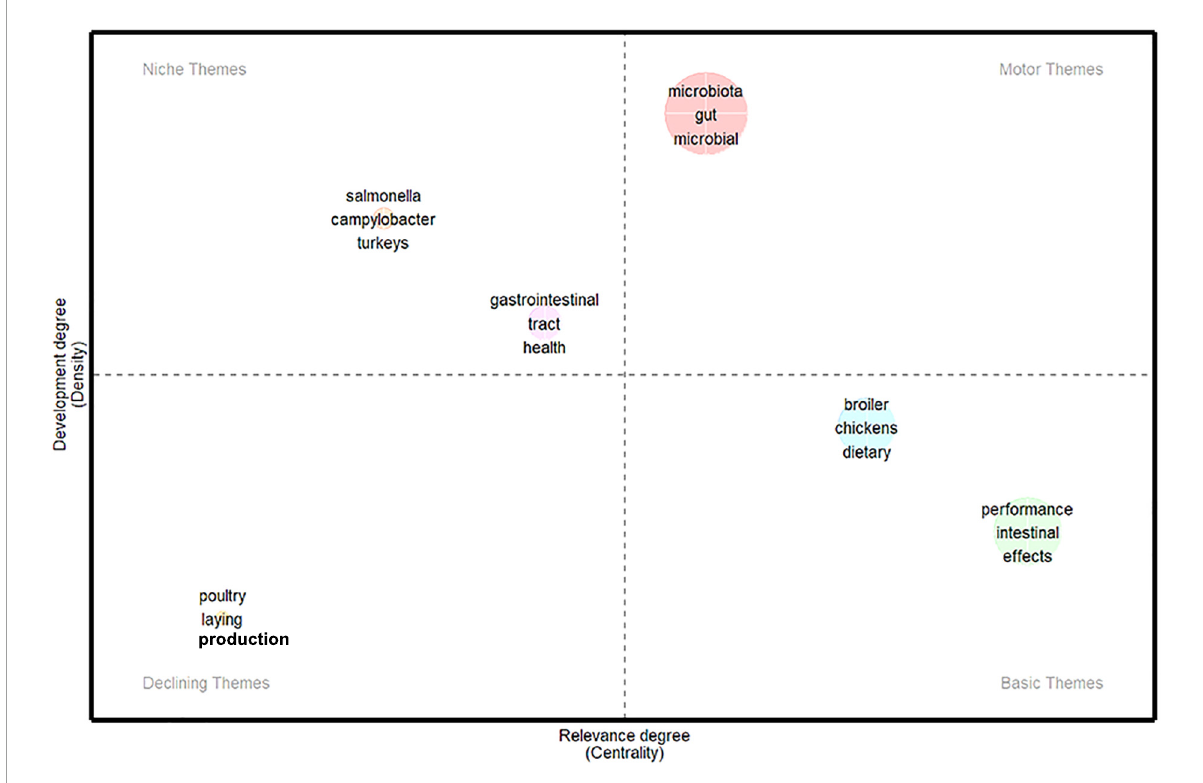
FIGURE2 The thematic map of keywords analysis from 2006 to